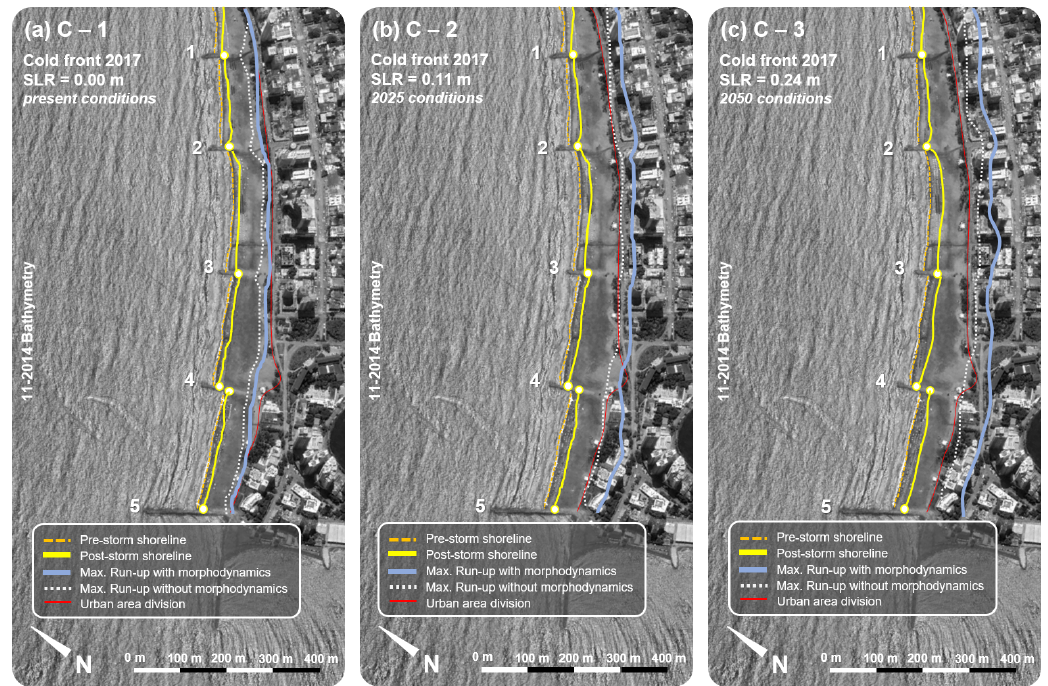
Figure 5. Maximum flood range (with and without morphodynamics) and post-storm shorelines simulated by XBeach for a storm similar to 2017 cold front with different SLR conditions. Map base images retrieved from © Google Earth and modified by the